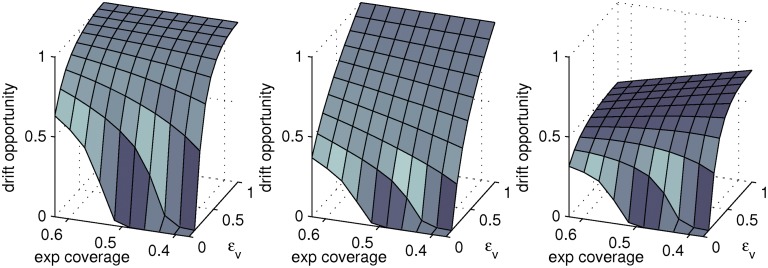
Drift opportunity in scenario C.Drift opportunity for scenario C with targeted distribution of a vaccine stockpile sufficient for 50 per cent coverage and assuming that pre-vaccination R
eff = 2. The axis labelled ϵ
v indicates the relative infectiousness of vaccinated and unvaccinated naïve hosts and “exp coverage” indicates the fractional vaccine coverage in experienced hosts (vaccine distribution is random when exp coverage is 0.5). Each panel corresponds to a different assumption regarding the form for the per infection rate of antigenic emergence g
0,i; equal probability per infection (left), proportional to host infectiousness (middle), and zero for vaccinated hosts with existing CTL protection (right). The vertical axis show the probability of emergence P
emg of an antigenically novel variant over the course of the epidemic relative to the same scenario without intervention.